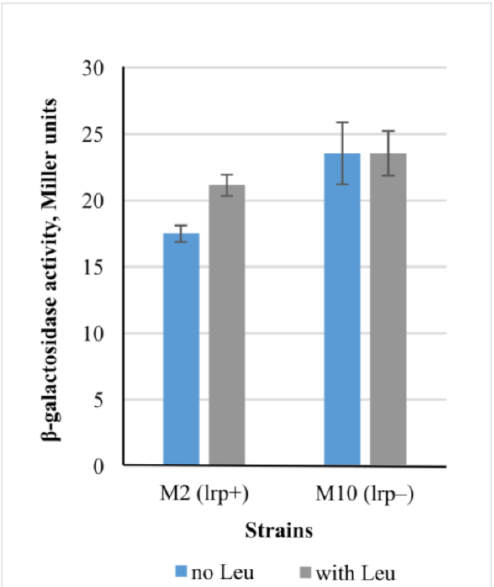
Figure 7. Influence of Lrp in the presence or absence of Leu on the expression level of lacZ gene under control of P cycA regulatory region. Strains M2 ( lrp +) and M10 ( lrp − ) (with or without lrp gene, respectively) were incubated in M9 supplemented or not with 10 mM Leu at 37 ◦ C, and the β -galactosidase activity was measured at the exponential growth phase. The data are the mean values of three independent experiments, where each assay was performed in triplicate, shown with standard